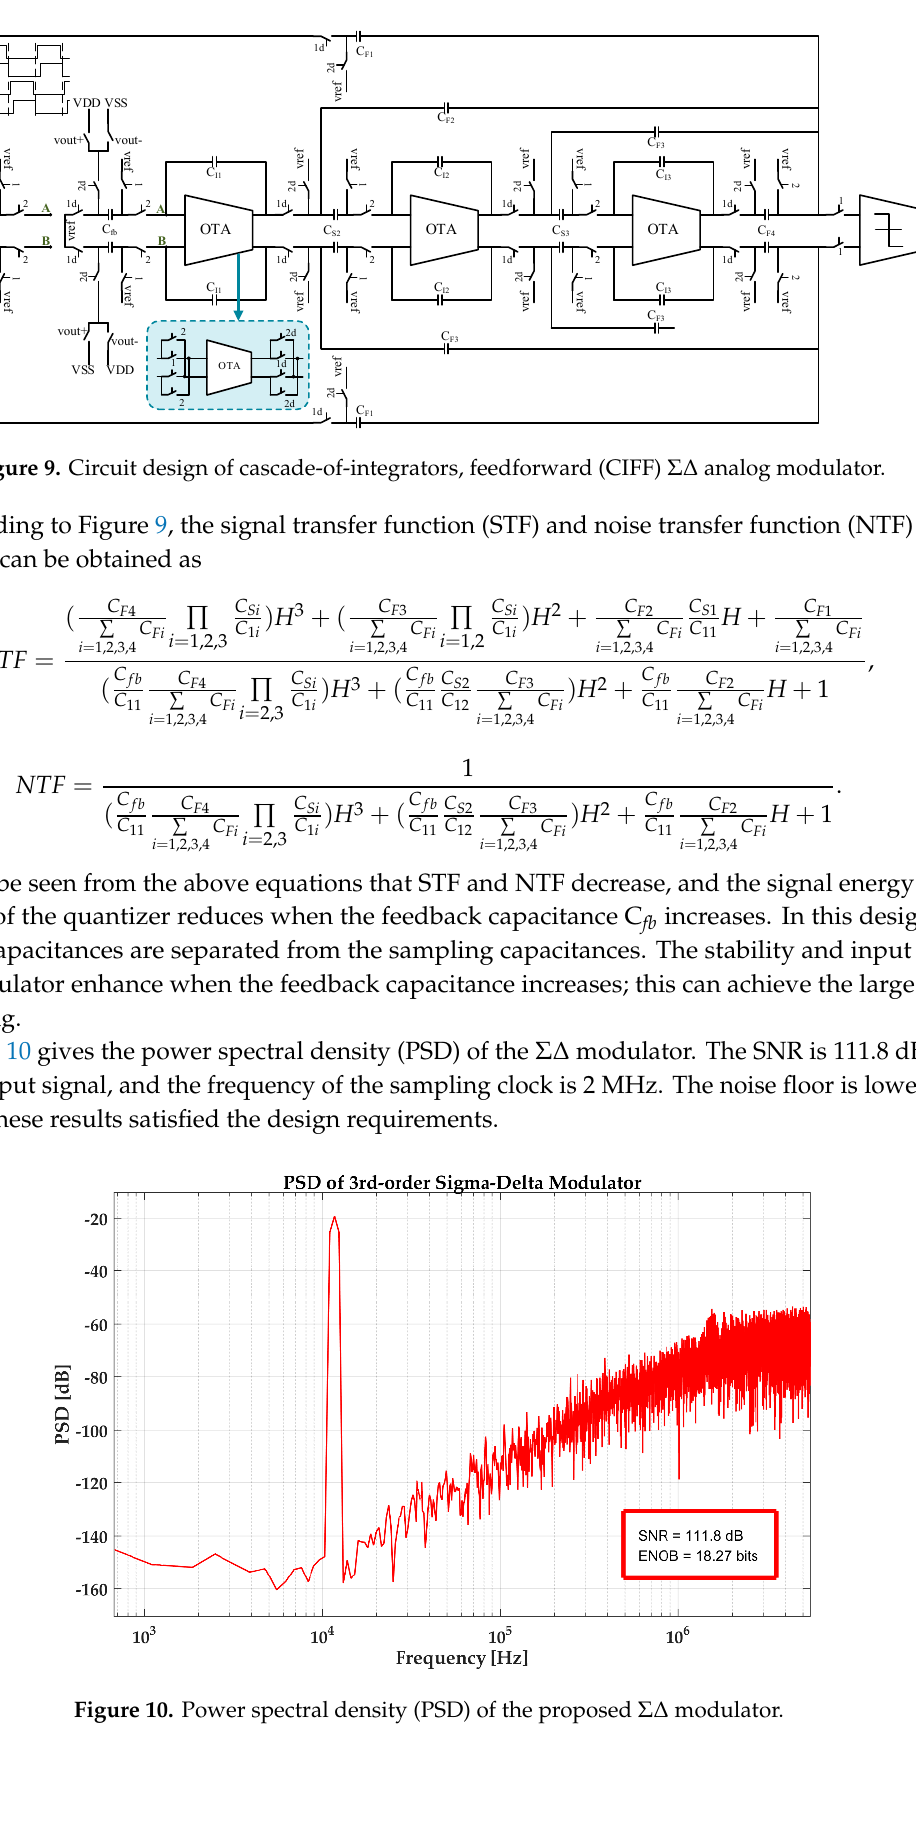
Figure 10. Power spectral density ( PSD) of the proposed ΣΔ modulator.